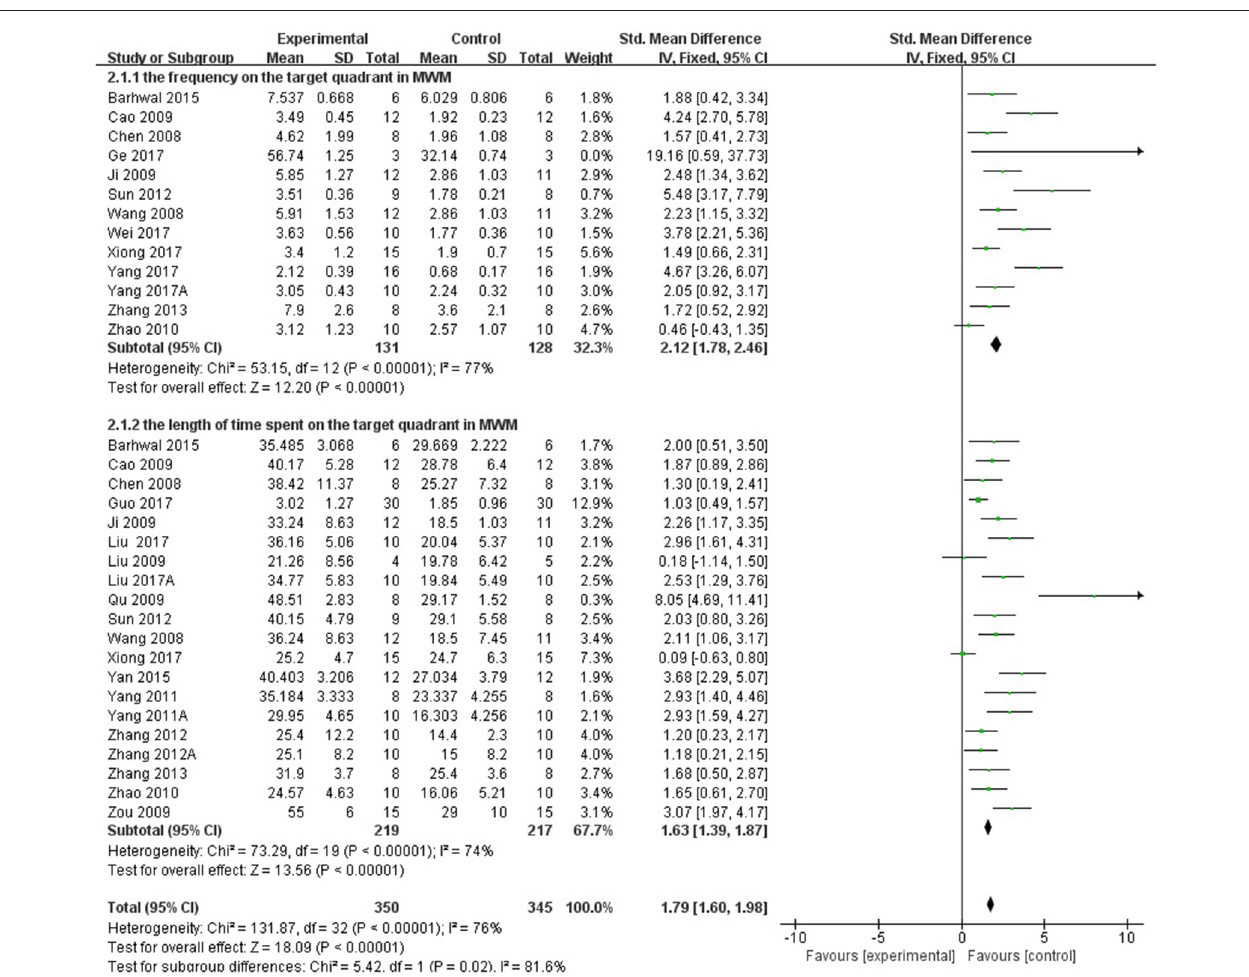
FIGURE 3 | The forest plot: effects of Rhodiola rosea L. for decreasing the frequency and the length of time spent on the target quadrant in MWM compared with control group.